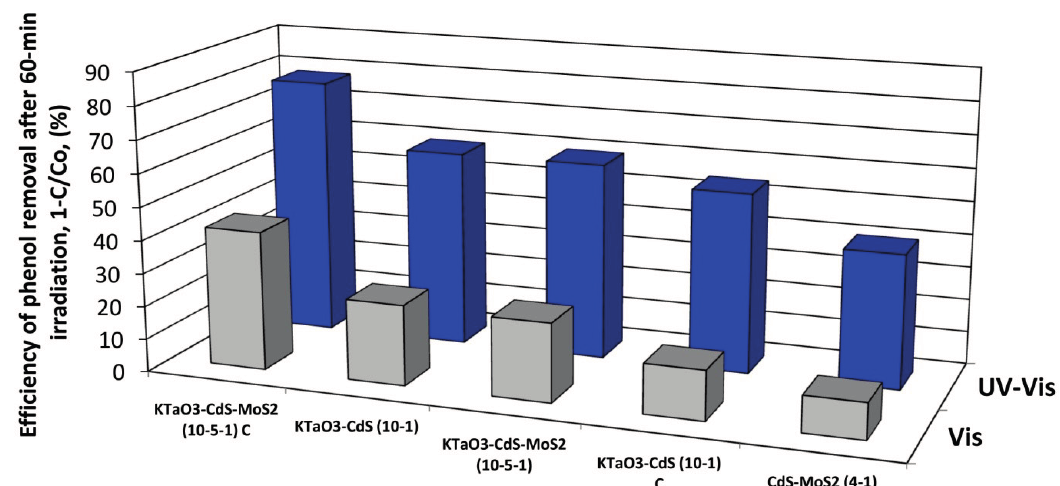
Figure 9. Efficiency of phenol removal under UV-Vis and visible light ( λ > 420 nm) for selected binary and ternary composites.